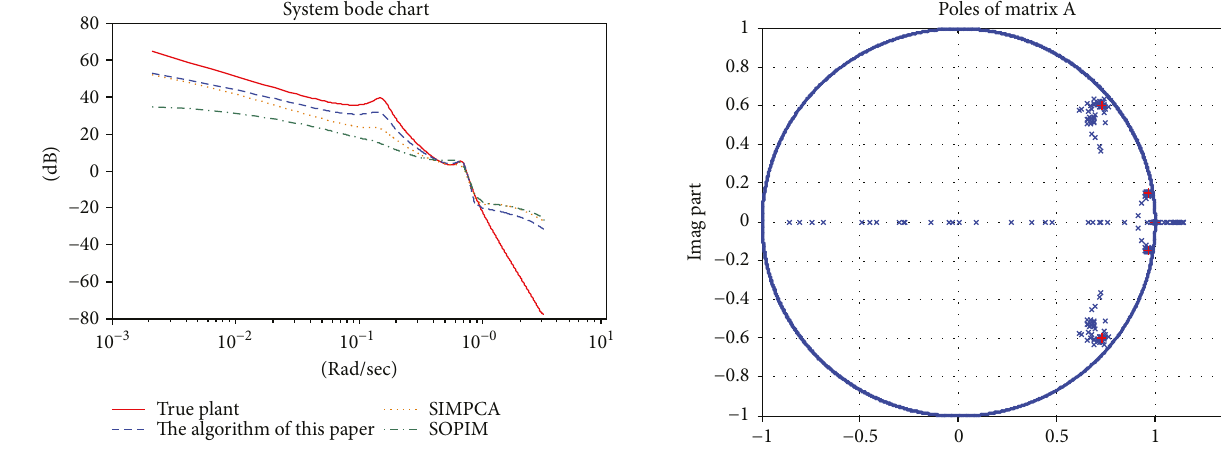
Figure 6: Comparison of Bode amplitude tracking curves among the three algorithms.